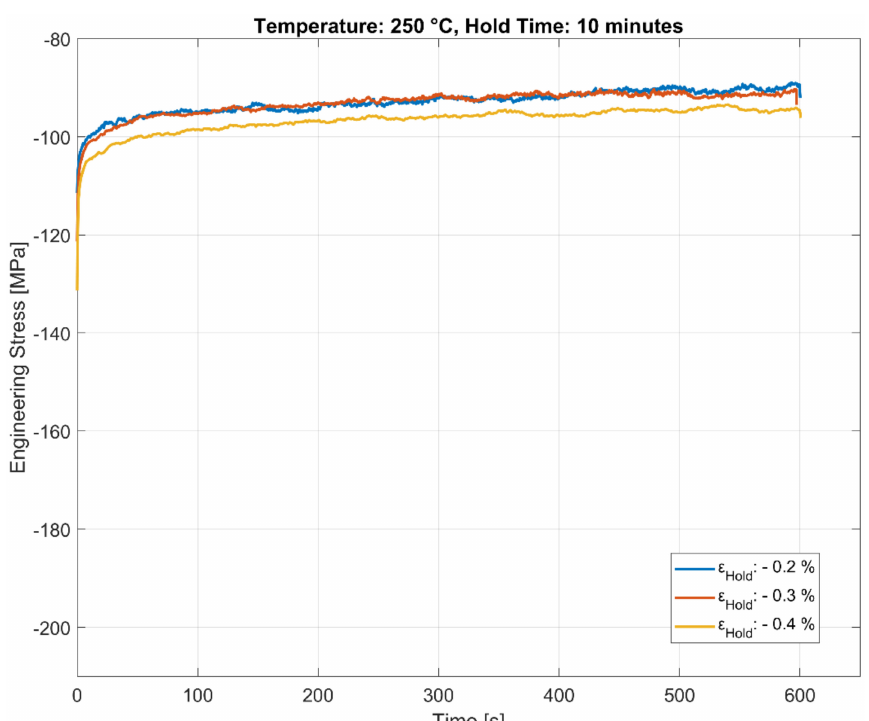
Figure 9. E ff ect of strain amplitude on stress relaxation at 250 ◦